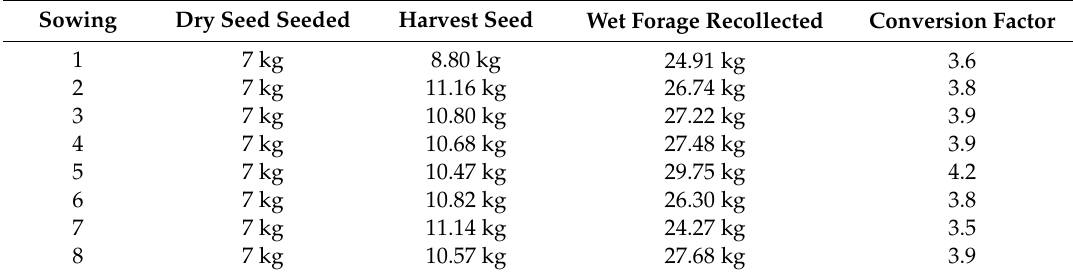
Table 5. Results of the hydroponic green forage of Hordeum vulgare for a production cycle of 12 days. Sowing Dry Seed Seeded Harvest Seed Wet Forage